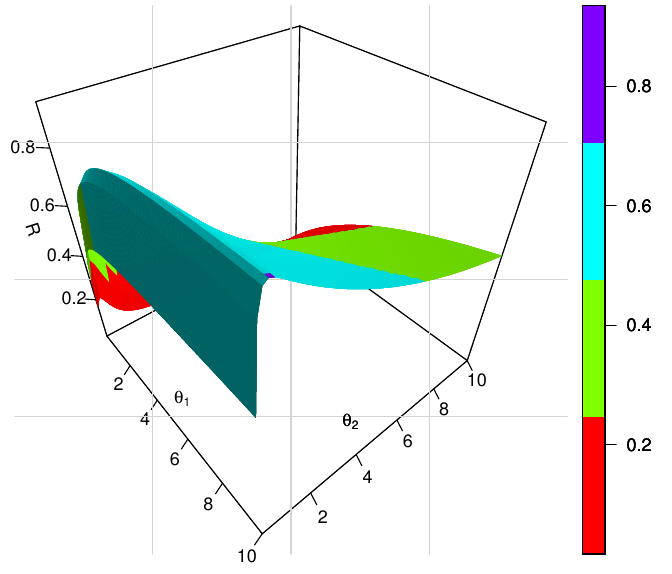
Figure 2. The reliability R = P ( X < Y )